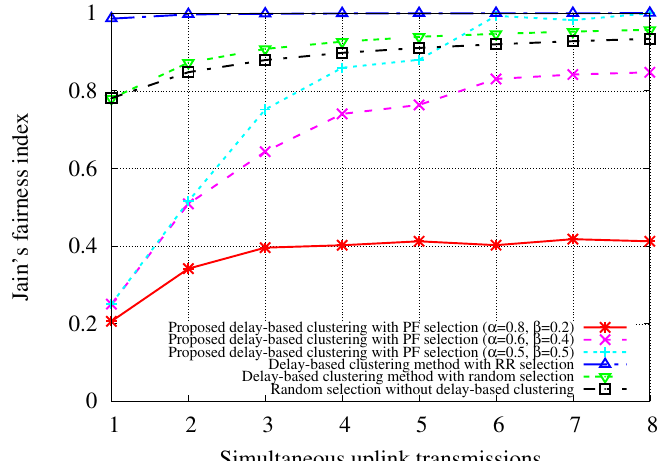
Figure 5. Fairness performance ( S =